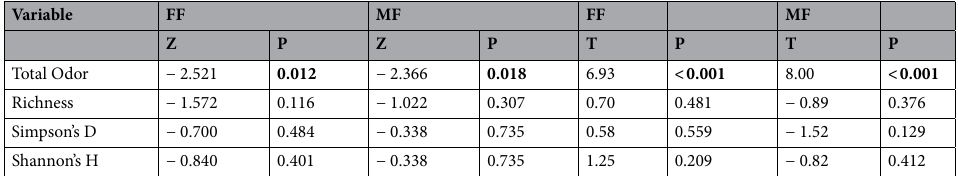
Table 4. Evaluation of the differences between fertile phase and non-fertile phase. Results from Wilcoxon Matched Pairs tests (tests conducted with 7 MF cycles and 8 FF cycles*) and pairwise comparisons (tests conducted on the whole datasets after having fitted GLMMs using two categories for individual cycle*). Bolded p-values are significant. *For results using one cycle per female or four categories for individual cycle, see Supplementary Table